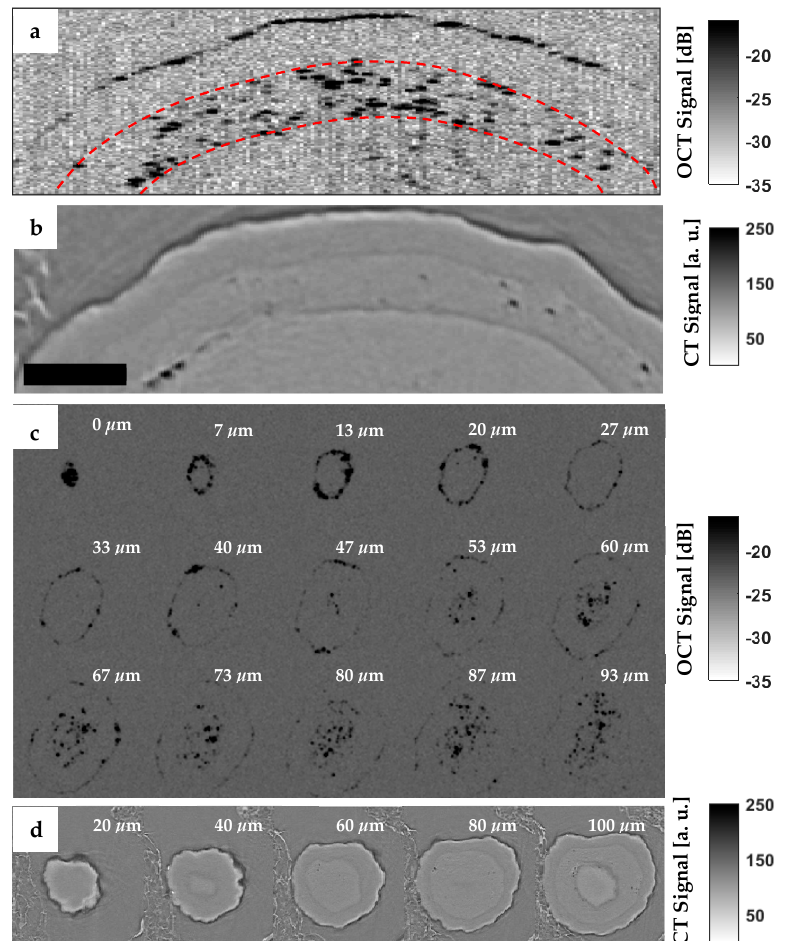
Figure 4. B-scan and en face images captured with full-field optical coherence tomography (FF-OCT) for characterising the micro-structure of a double-layer coated pellet. The FF-OCT B-scan in ( a ) and the en face results in ( b ) are validated by X µ CT in ( b , d ) on the same pellet sample. Two dashed red lines in ( a ) indicate the upper and lower interfaces of the inner coating layer. Adapted from